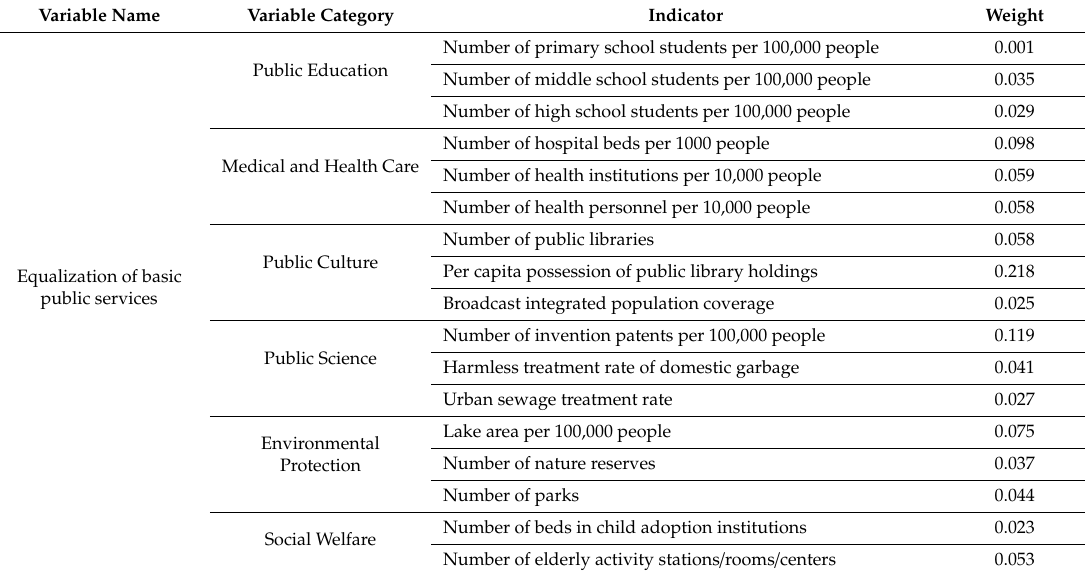
Table 1. Dependent variables and